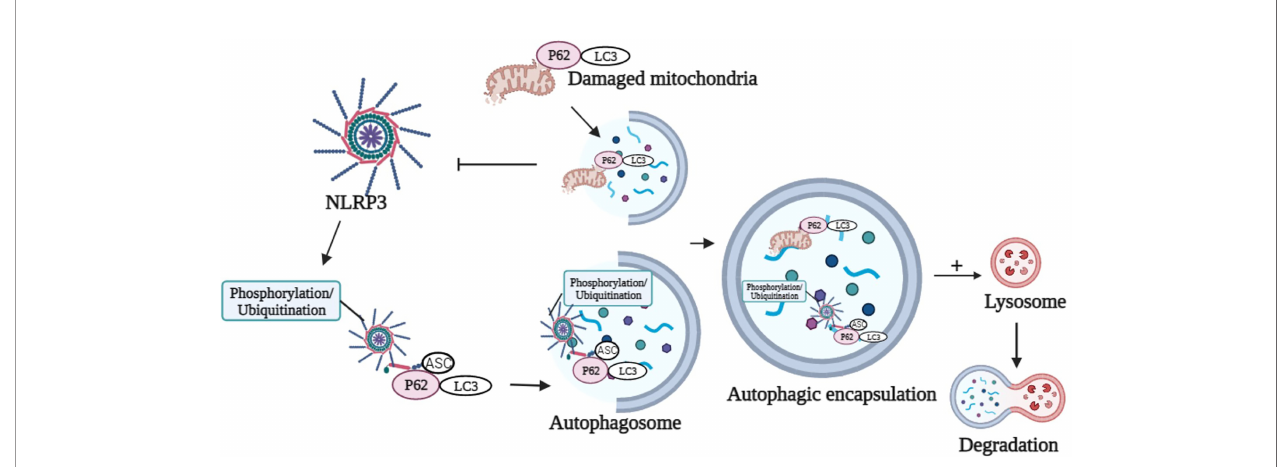
FIGURE 2 | Graphical representation of p62 in the modulation of NLRP3 activation and degradation. p62 binds damaged mitochondria to reduce NLRP3 in fl ammasome activation. Phosphorylation or ubiquitination of NLRP3 interacts with p62 in an ASC-dependent manner and sequesters in phagosomes for degradation. Image created with